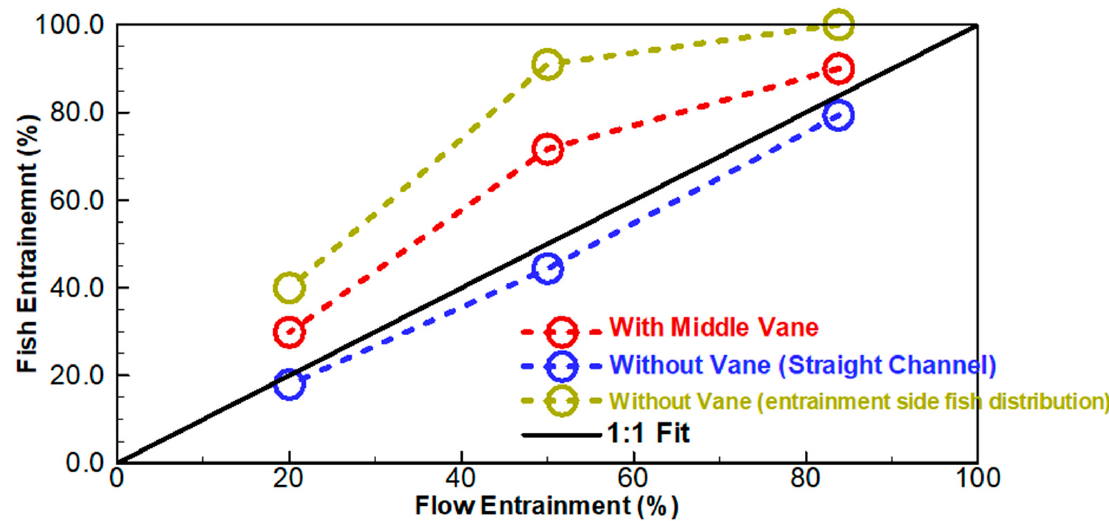
Figure 13. Computed fish entrainment rate for the vane case with the top-half fish distribution at the inlet (the top-half and entrainment-half results for the no-vane baseline cases are also shown).